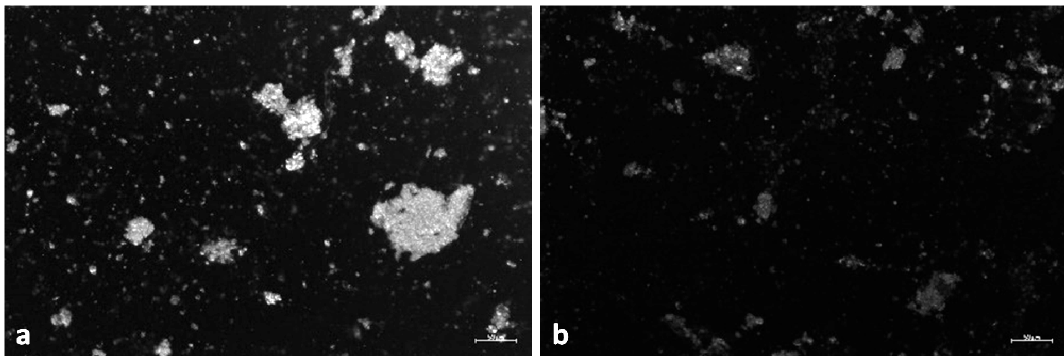
Figure 4. Digestion efficiency evaluation after ( a ) amylase-lipase-papain digestion and ( b ) after additional SDS purification step. Scale bar 50 µm.